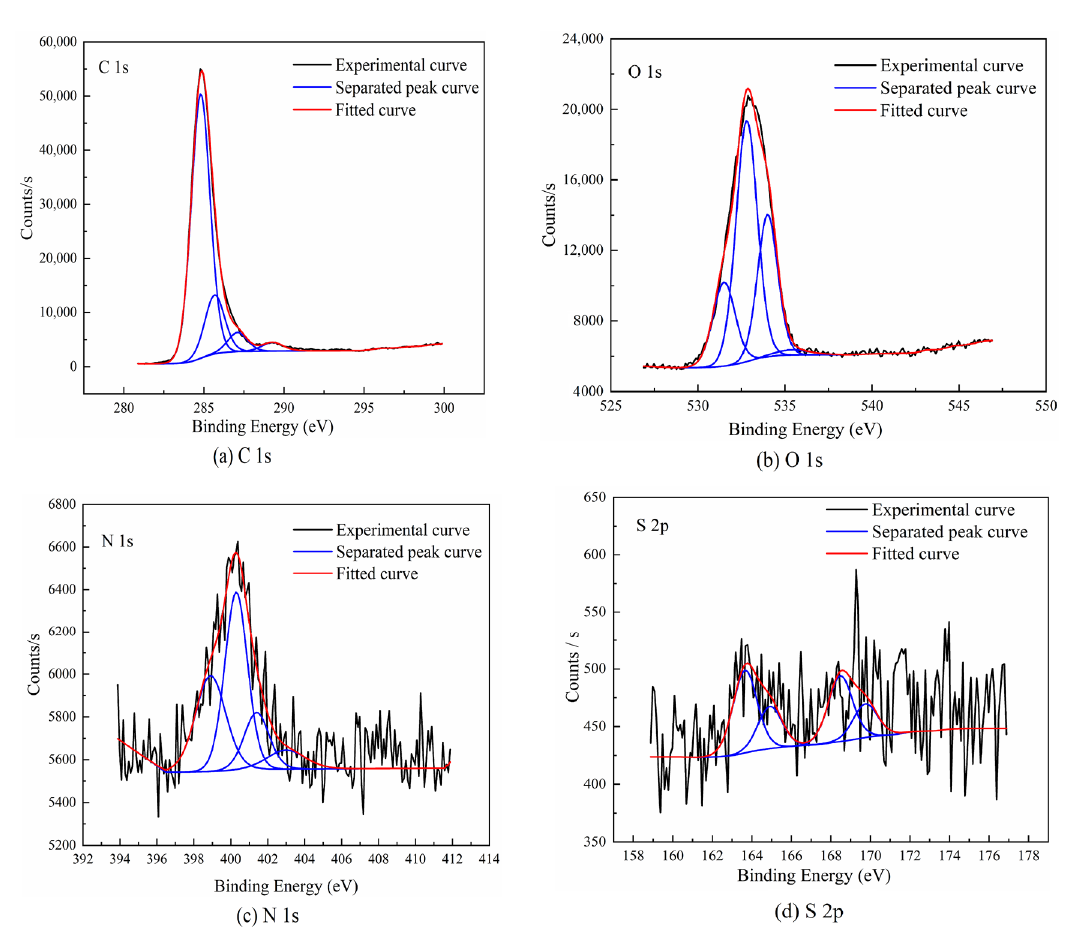
(cid:0) (cid:1) + f P + f S f H / =0.197. It reflects the average value of the condensation a a a a